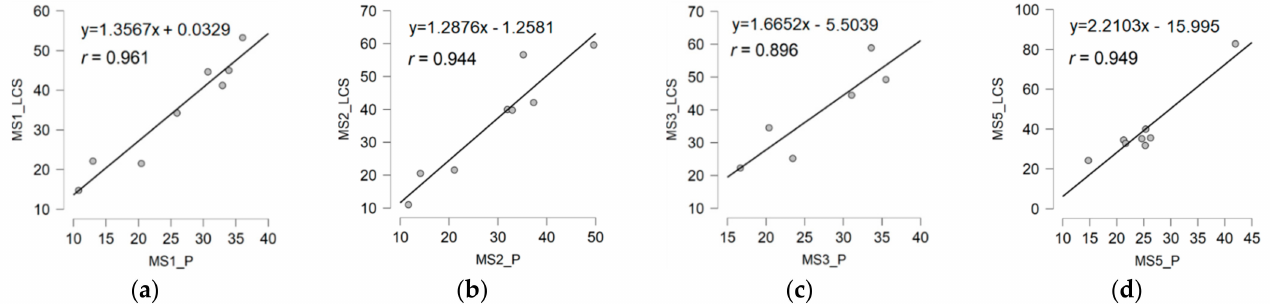
Figure A1. PM 2.5 correlation: ( a ) MS1 site reference pump vs. low-cost device ( b ) MS2 site reference pump vs. low-cost device ( c ) MS3 site reference pump vs. low-cost device ( d ) MS5 site reference pump vs. low-cost